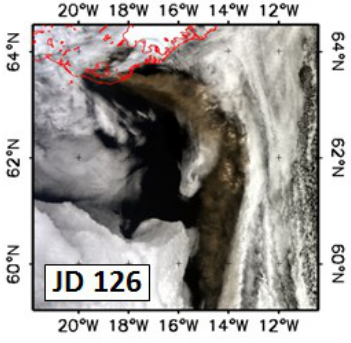
Figure 1: RGB (channels 1-4-3) color composite of MODIS images acquired 6th, May 2010 (JD 126) during the Ejafjallajökull eruption (coastline plotted in red), used to train the